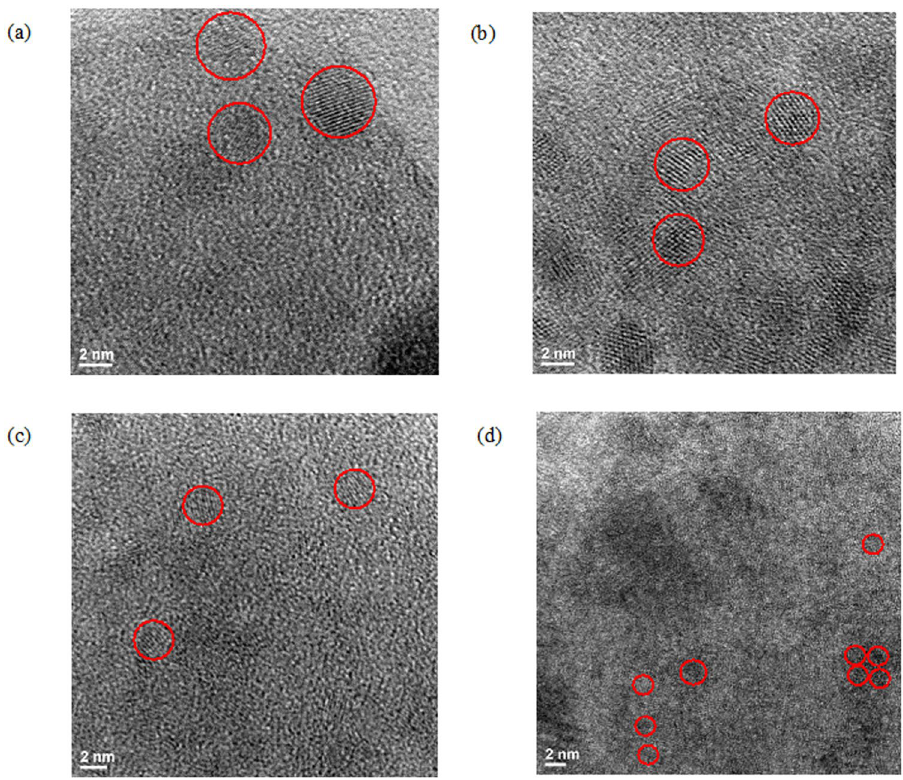
Figure 5. TEM images for ( a ) 0 min ( b ) 10 min ( c ) 15 min & ( d ) 30 min ozone treated samples. The estimated average graphitic carbon cluster sizes for these samples are 3.69, 1.85, 1.73, and 1.28 nm, respectively. Representative regions are circled in red, however all ordered sp2 regions were considered in the